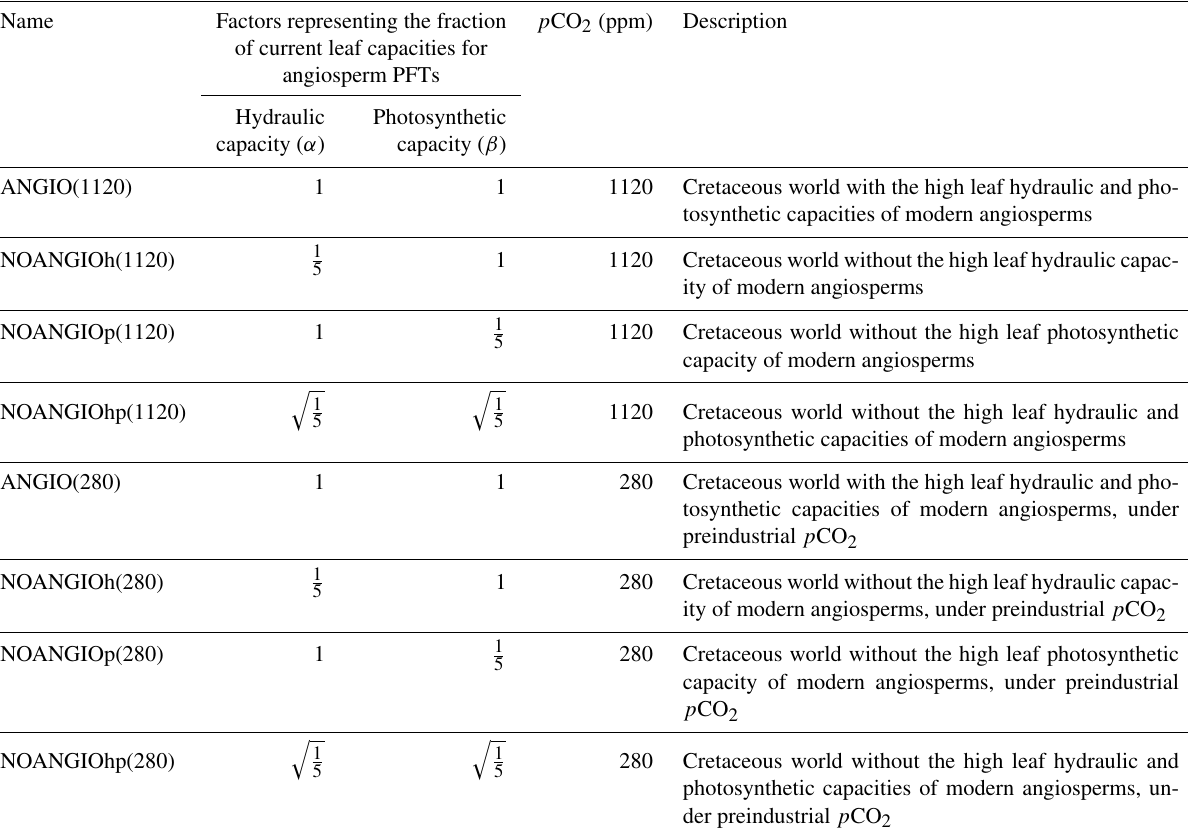
Table 2. Definition of the